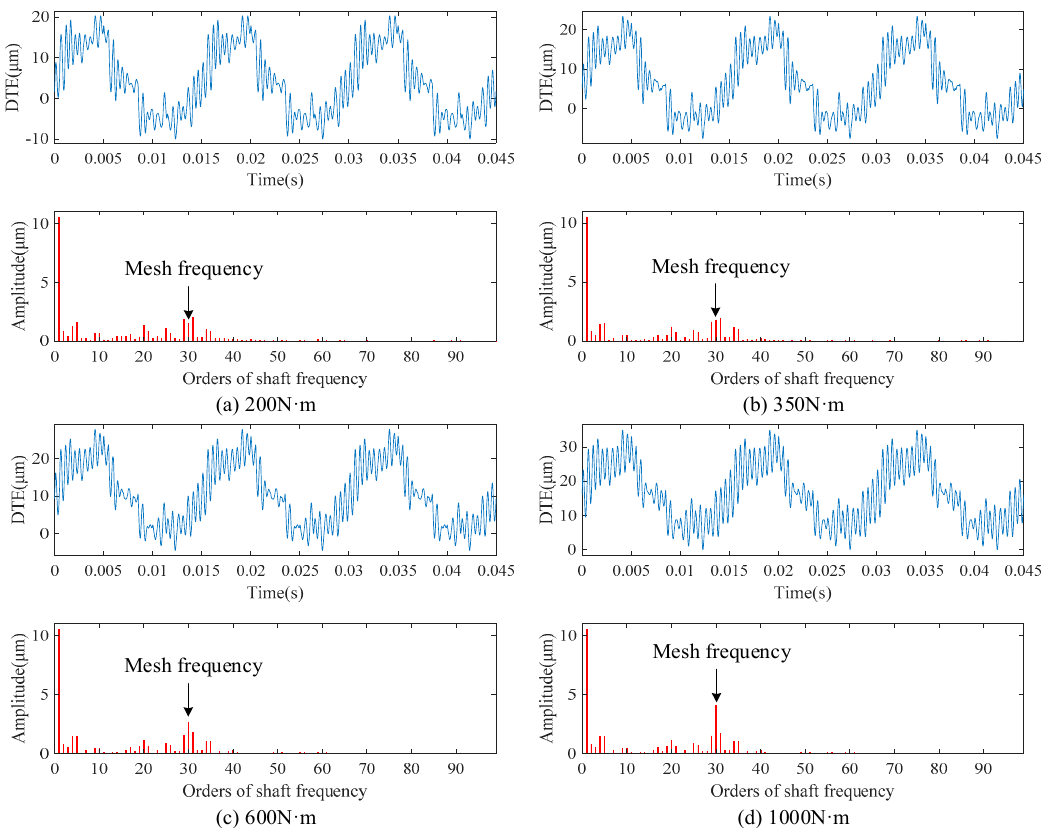
Figure 11. DTEs at di ff erent load torques considering random cumulative pitch deviations. For bearing 1, the vibration acceleration along y direction at di ff erent load torques are shown in Figure 12. As similar as DTE, the frequency components of bearing vibration acceleration also become complex. The sideband frequencies f m ± if s ( i = 1, 2, . . . , n ) appear in the two sides of MFIHs. Some sideband frequencies are larger than mesh frequency when load torque is smaller than 600 N · m. As the load torque increases, mesh frequency amplitude will increase correspondingly. When the load torque is larger than 1000 N · m, the mesh frequency becomes the most predominant. Unlike DTEs, the shaft frequency is not the most predominant frequency in bearing vibration acceleration.